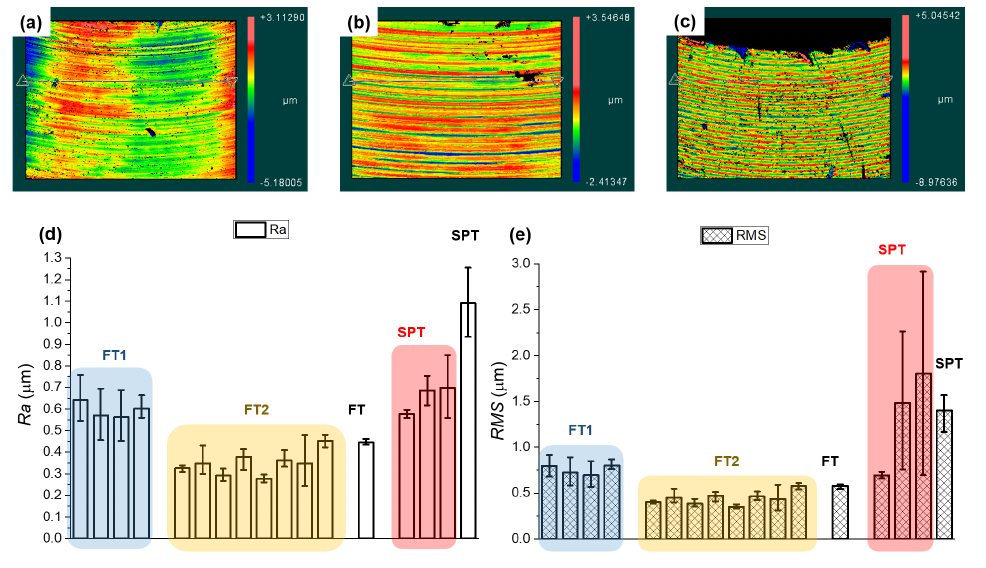
Figure 11. Surface morphology and surface roughness of as-machined nuts. ( a ) FT1. ( b ) FT2. ( c ) SPT. Note that the color–height scale is different in each case. ( d ) The average roughness, R a . ( e ) Root mean square roughness R q . Results from Swagelok nuts machined by the same method are grouped and marked by colored shading. Non-grouped nuts are from other